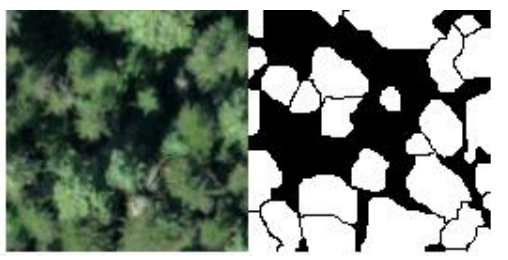
Figure 1. The location of the study site (left) and the true colour composite of the optical imagery over this site (right). The two plots were used for independent testing.